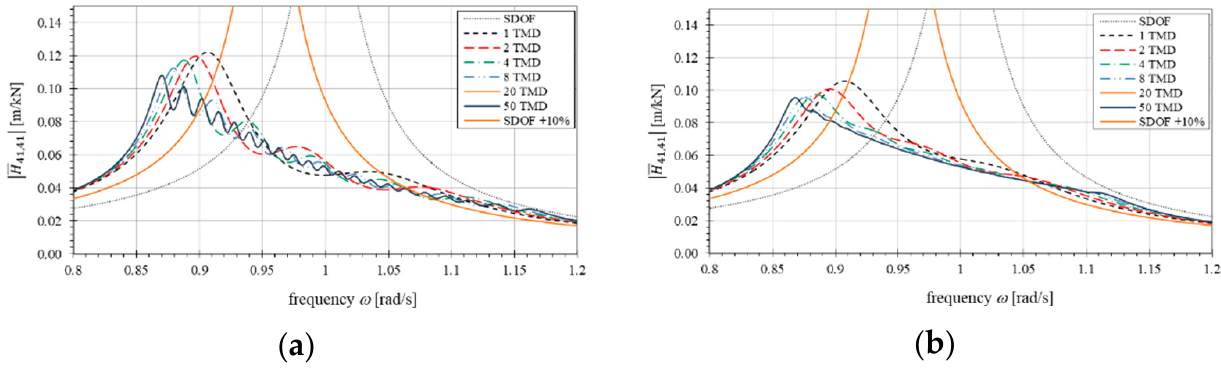
Figure 8. Module graph of a FRF (cid:12) H 41,41 (cid:12) with the mass of the primary system increased by 10% for optimal parameters and a different number of TMDs: ( a ) for the J 1 objective function; ( b ) for the J 2 objective function.